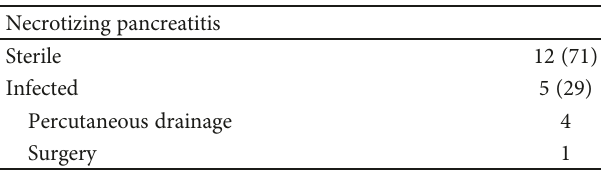
Table 5: Pancreatic infection status of the 17 patients with necrotizing pancreatitis and their